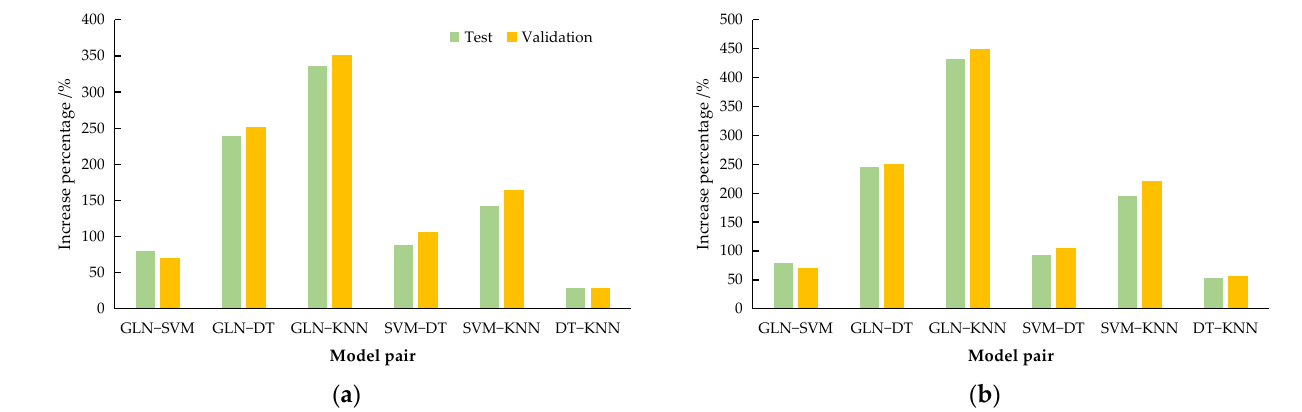
Figure 6. Assessment metric change comparison of different pairs of models. ( a ) Overall accuracy; ( b ) Overall F 1 score. GLN denotes the GoogLeNet model; SVM denotes the Support Vector Machine model; DT denotes the Decision Tree model; and KNN denotes the K-Nearest Neighbor model. GLN-SVM means the difference of the accuracy metrics for GLN and SVM, and the others are the same as this meaning.